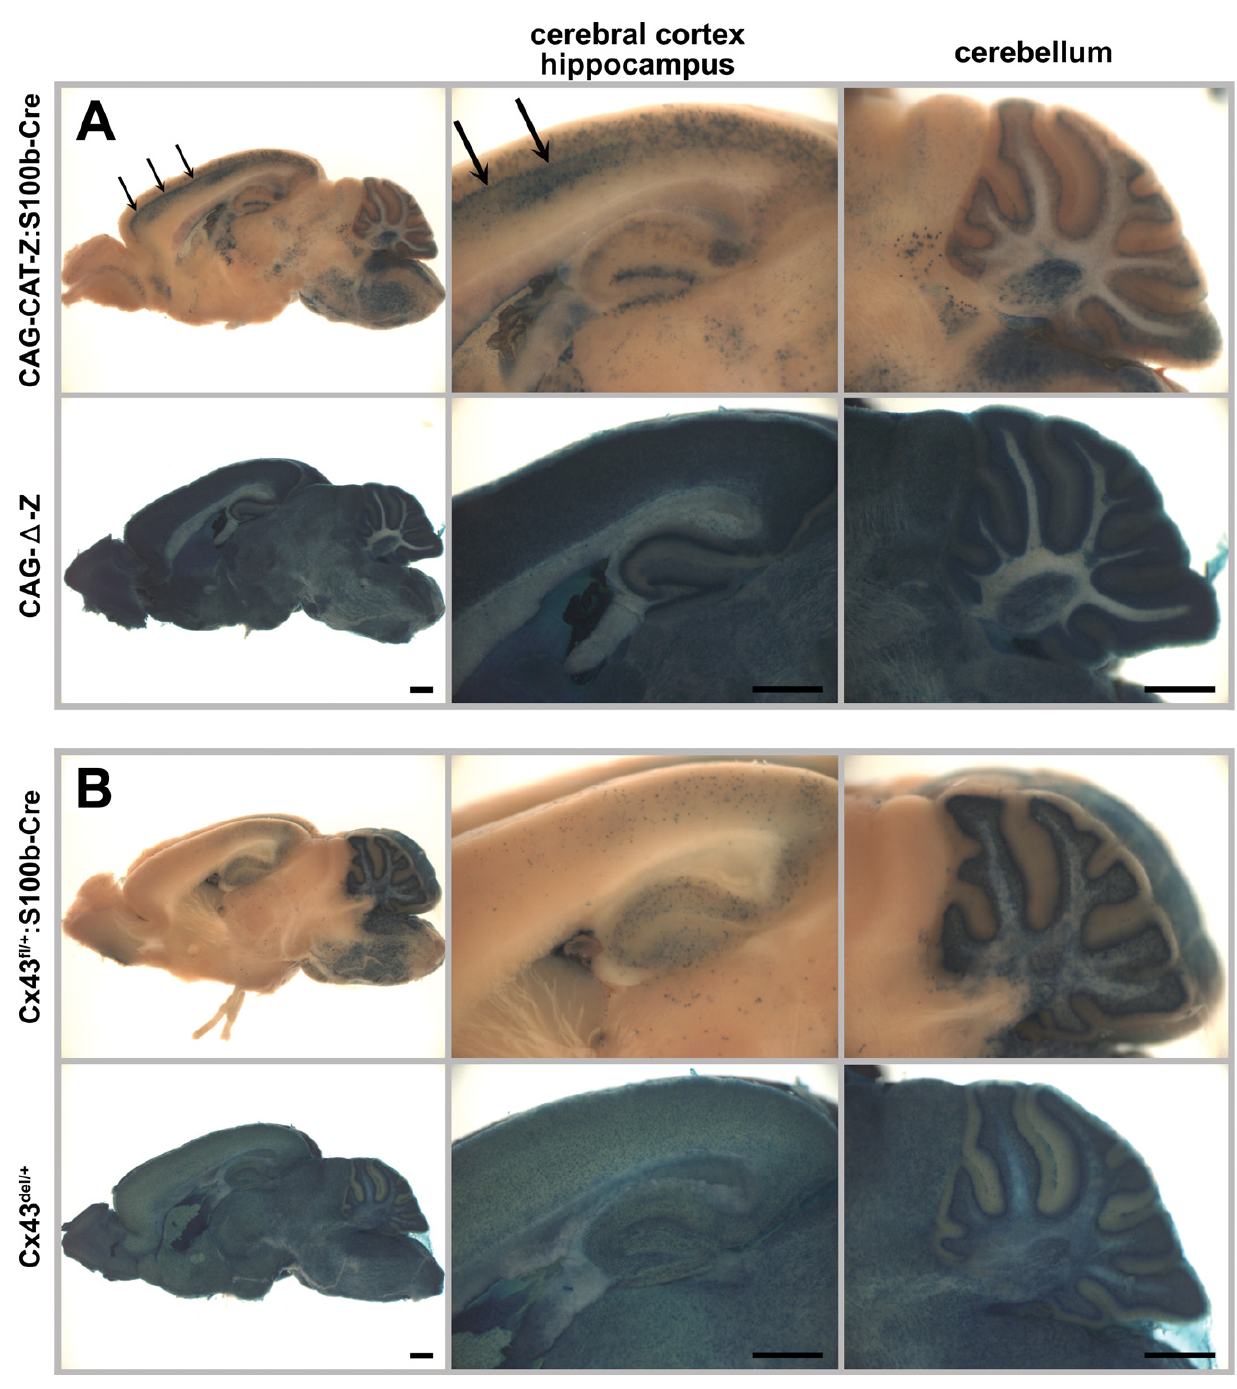
Figure 2. S100b-Cre -mediated recombination in the adult brain (2 month old). Cre-mediated recombination was assayed by whole mount β -galactosidase (lacZ) staining of parasagittal brain slices from CAG-CAT-Z:S100b-Cre (A) and Cx43 fl/ + :S100b-Cre (B) mice. CAG- Δ -Z (Iwasato et al., 2000, 2004) (A) and Cx43 del/ + (Theis et al., 2001) (B) mice served as positive controls. Note that β -galactosidase is localized in the cytoplasm in (A) and in the nucleus in (B) . There were no lacZ-positive cells observed in CAG-CAT-Z or Cx43 fl/ + mice (data not shown). (A) In CAG-CAT-Z:S100b-Cre mice, cells with weak and/or unclear lacZ staining were observed in the cerebral cortex, hippocampal CA1-CA3 region, cerebellum, and brainstem. Relatively strong lacZ staining was observed in the hippocampal dentate gyrus. In the cerebral cortex of CAG-CAT-Z:S100b-Cre mice, intensive lacZ staining forming a layer-like pattern was found (arrows). In the cerebellum, lacZ staining was observed in the Purkinje cell layer, granule cell layer, white matter, and deep cerebellar nucleus. (B) LacZ staining of Cx43 fl/ + :S100b-Cre mice was the most intensive in the cerebellum as compared to positive controls. In the cerebellum, lacZ-positive cells were observed in Purkinje cell layer, granule cell layer, white matter, and deep cerebellar nucleus, consistent with the lacZ staining pattern observed in CAG-CAT-Z:S100b-Cre mice (A) . LacZ-positive cells were also observed with less frequency in the cerebral cortex, hippocampus, and brainstem. Scale bar, 1